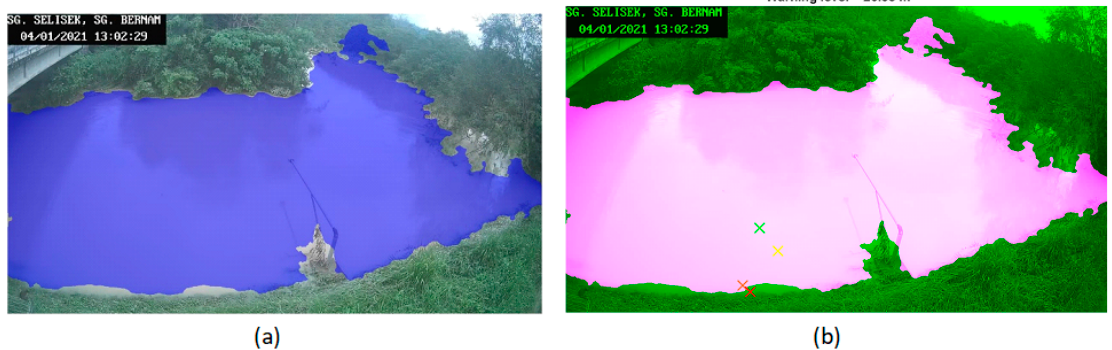
Figure 13. Failure in water detection during the segmentation process led to an error in water level estimation. ( a ) The segmentation result overlaid with the original image. ( b ) The estimated river water level and its threshold class.